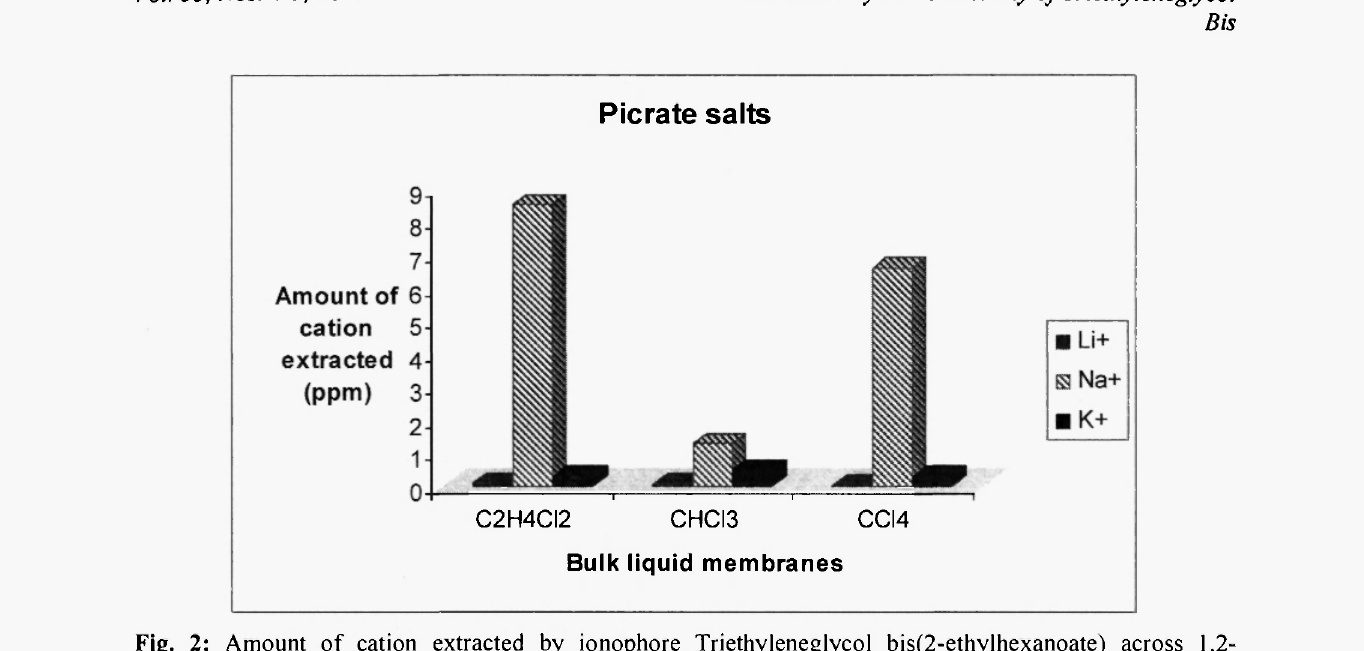
Fig. 2: Amount of cation extracted by ionophore Triethyleneglycol bis(2-ethylhexanoate) across 1,2- dichloroethane, chloroform and carbontetrachloride membranes using metal (Li + , Na + and K + ) picrates after 4 hrs; Aqueous phase (50) ml of metal picrate solution (conc" = lx 10" 1 M); Organic phase (50 ml).